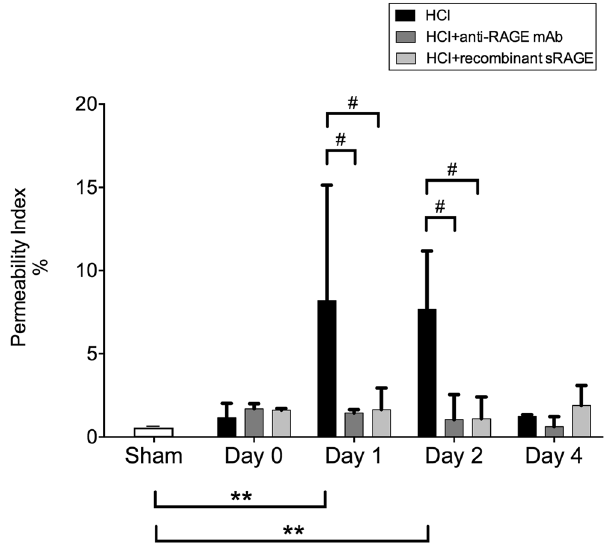
Figure 2. RAGE inhibition enhances the alveolar capillary barrier. The permeability index calculated as the bronchoalveolar lavage (BAL) fluid-to-plasma ratio of the human serum albumin (HSA) concentration in uninjured, untreated mice (Sham group), acid-injured animals (HCl group) and acid-injured animals treated with sRAGE (HCl + recombinant sRAGE group) or with anti-RAGE monoclonal antibody (HCl + anti-RAGE mAb group) (n = 4–6 for each time-point). As no difference was observed between sham animals at all time points; the results from sham mice were mixed for analyses (left bar of the X-axis). Values are reported as means ± standard deviations. ** P < 10 − 2 versus sham controls, # P < 0.05 versus acid-injured